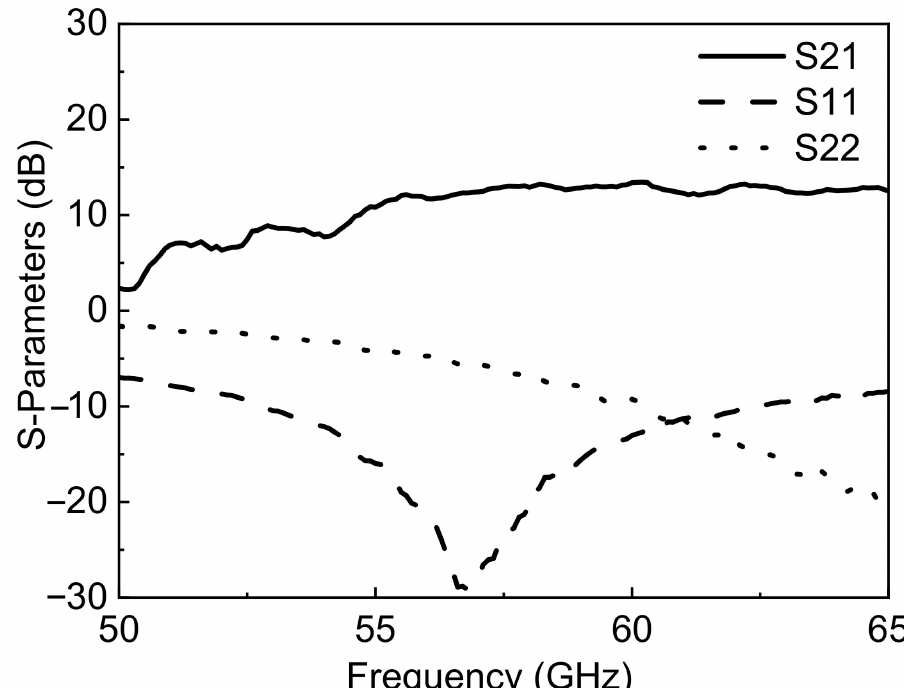
Figure 9. Measured S-parameters of the 60 GHz LNA test